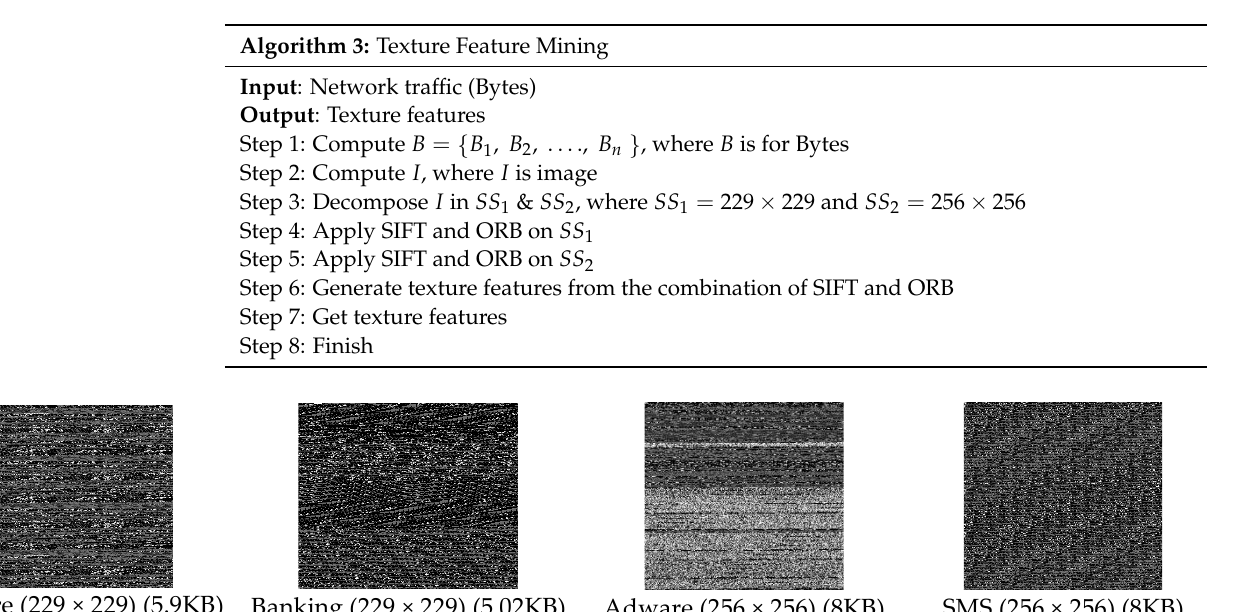
Algorithm 2: Trained Feature Mining